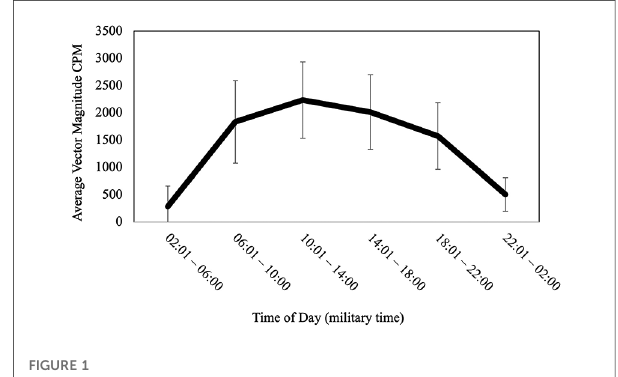
FIGURE 1 Activity patterns across the 24-hour cycle.